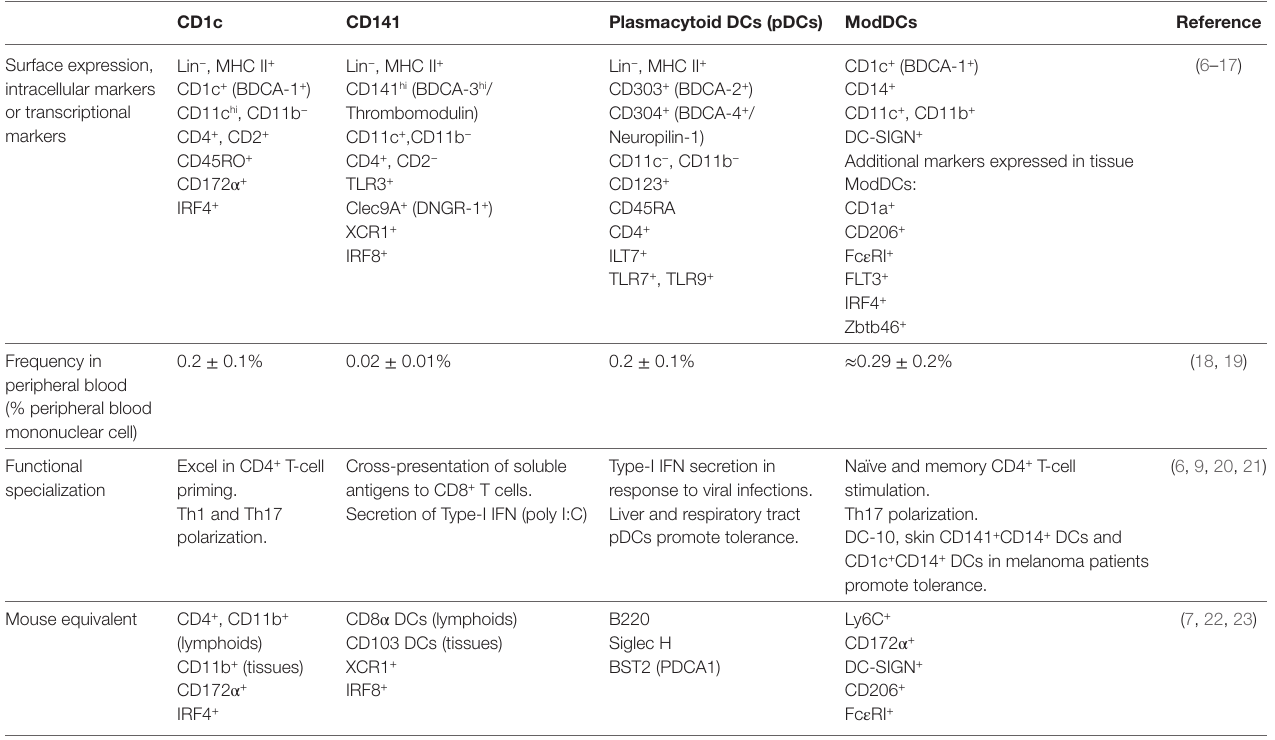
Table 1 | Characteristics of blood human dendritic cells (DCs) and monocyte-derived DCs (ModDCs) subsets. CD1c CD141 Plasmacytoid DCs (pDCs) ModDCs